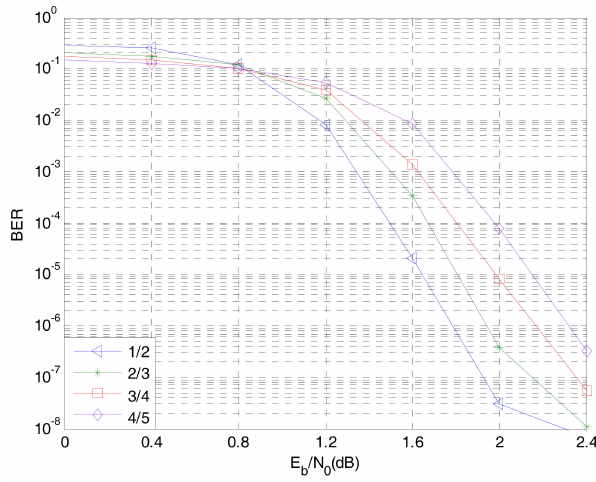
Figure 11. The influence of different code rate on the performance of 8-ary LDPC-CPM system.